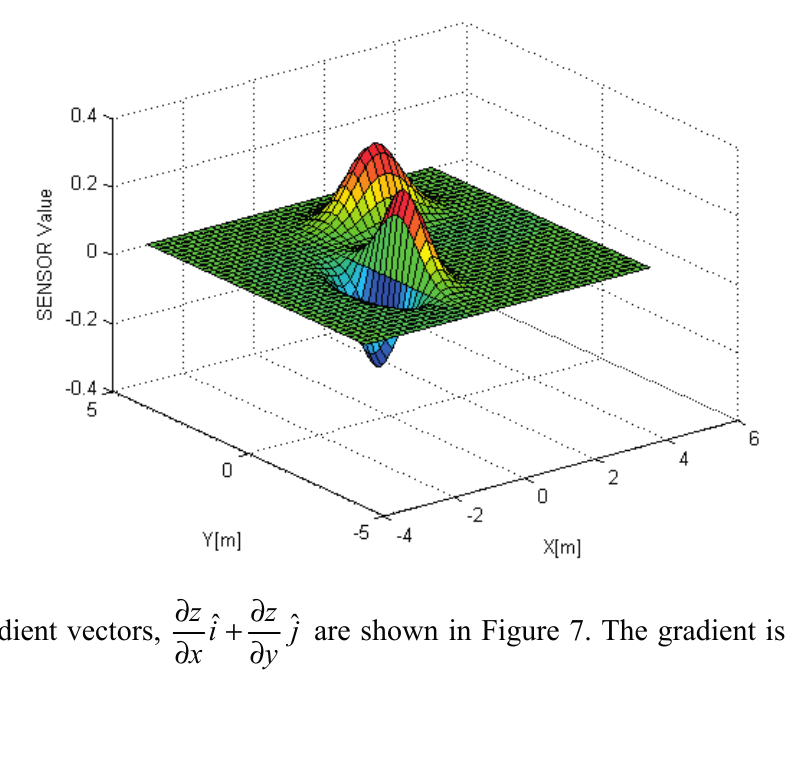
Figure 6. Environment model: surface